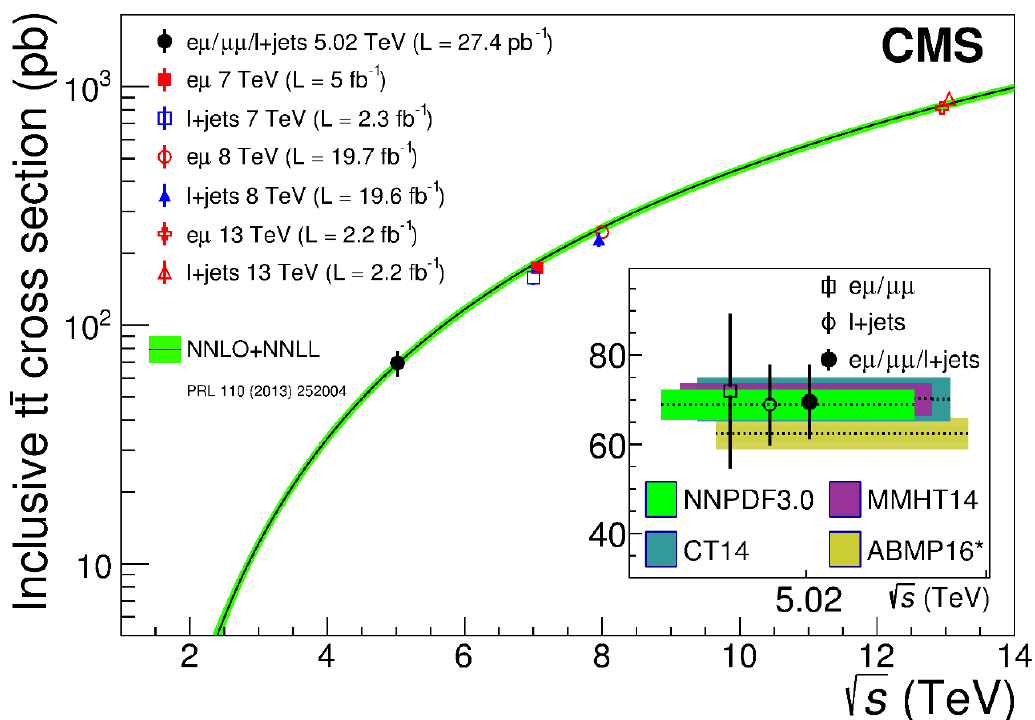
Figure 5 . Inclusive (cid:27) in pp collisions as a function of the center-of-mass energy; previous CMS tt p measurements at s = 7, 8 [5, 6], and 13 [9, 10] TeV in the separate ‘ +jets and dilepton channels are displayed, along with the combined measurement at 5.02 TeV from this analysis. The NNLO+NNLL theoretical prediction [34] using the NNPDF3.0 [14] PDF set with (cid:11) s ( M Z ) = 0 : 118 and m top = p 172 : 5 GeV is shown in the main plot. In the inset, additional predictions at s = 5 : 02 TeV using the MMHT14 [54], CT14 [55], and ABMP16 [56] PDF sets, the latter with (cid:11) s ( M Z ) = 0 : 115 and m top = 170 : 4 GeV, are compared, along with the NNPDF3.0 prediction, to the individual and combined results from this analysis. The vertical bars and bands represent the total uncertainties in the data and in the predictions,